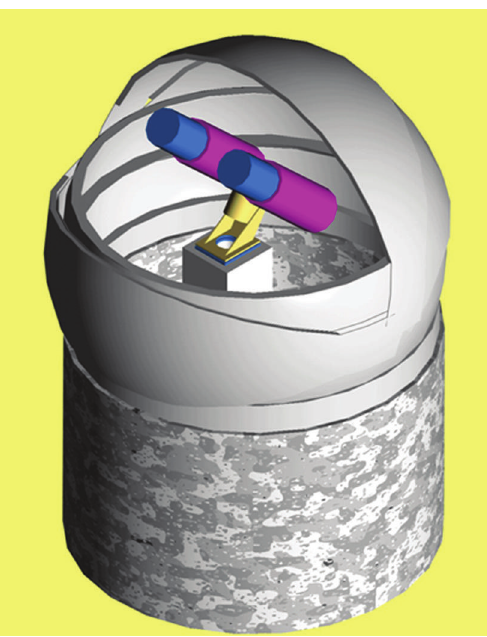
Figure 3: MASTER II wide-field robotic telescope (manufactured by OAO Optika Moscow Association). Each tube is equipped with a photometer with a set of B, V, R, I filters and polarizers.